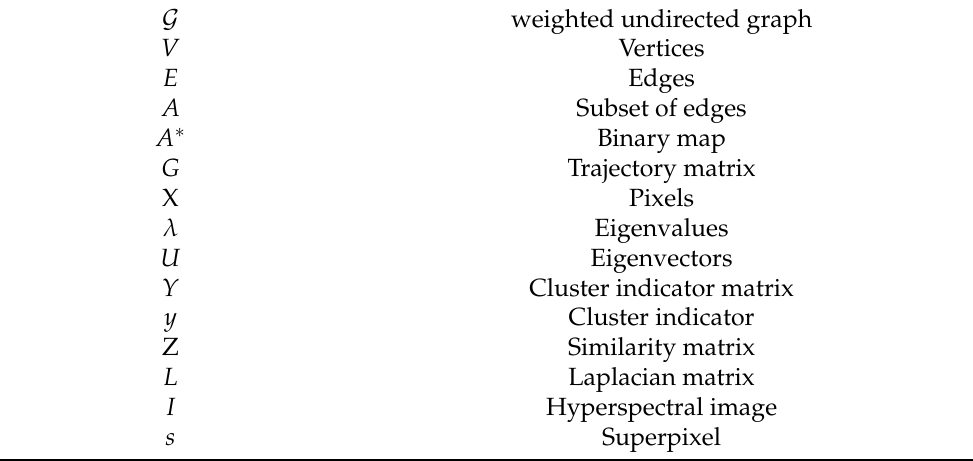
Table 1. List of symbols used in the